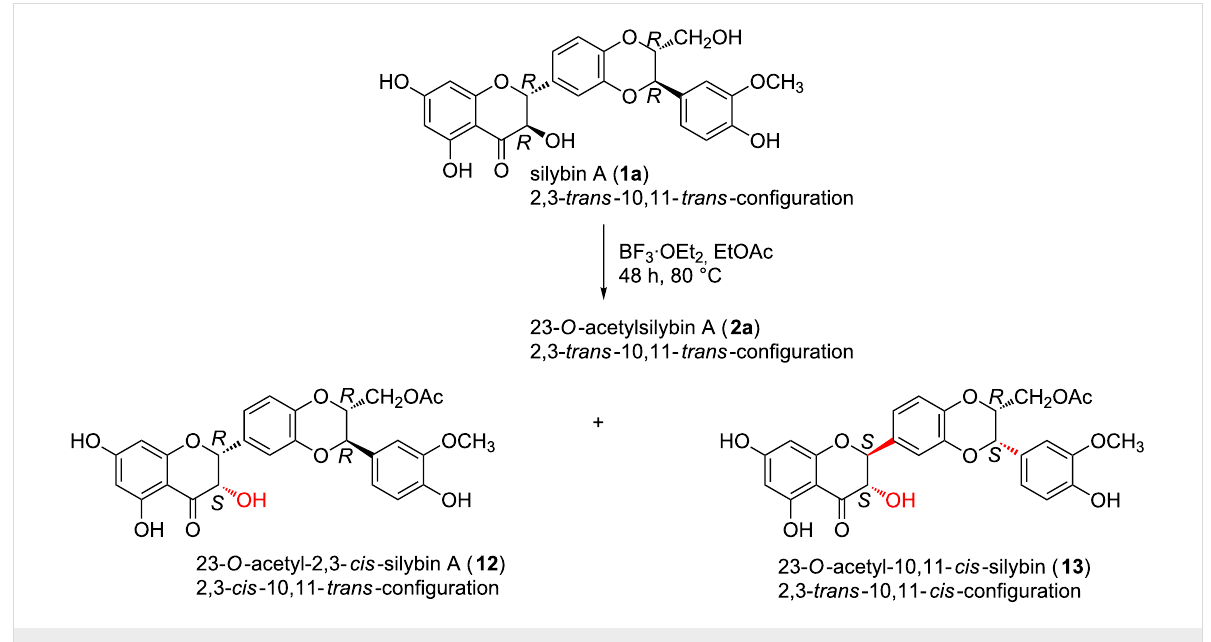
Scheme 3: Isomerization of silybin A in